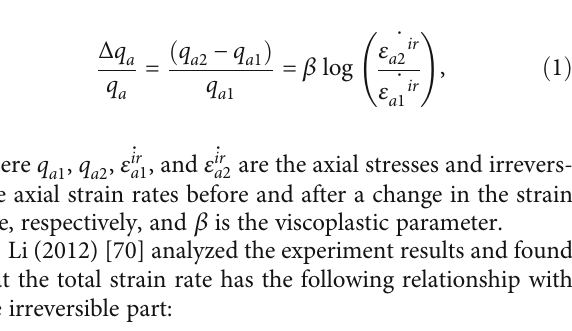
Strain rate toward